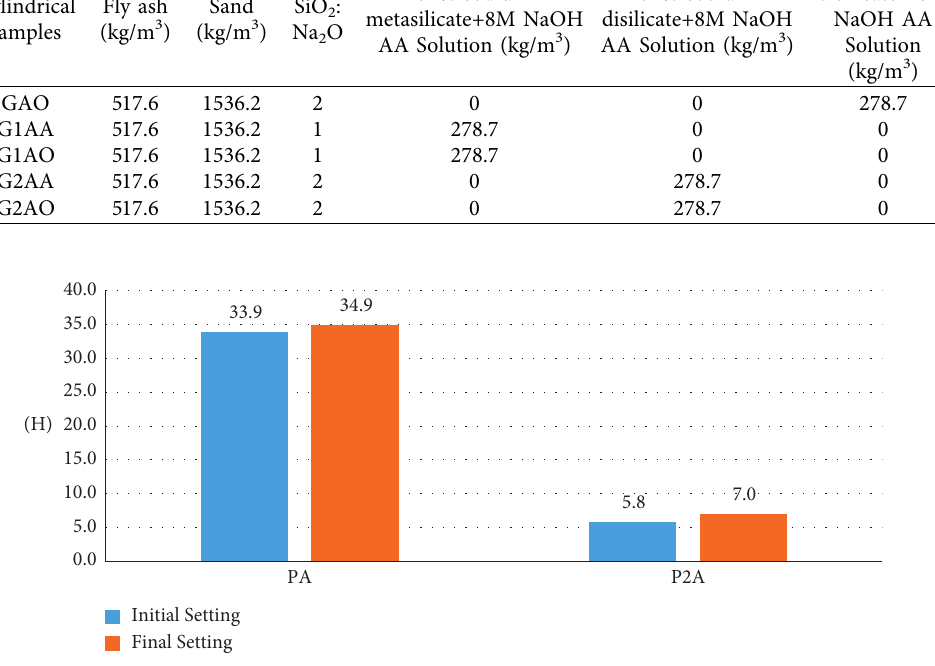
Figure 1: Influence of the change in concentration of sodium silicate solution on the setting time of the